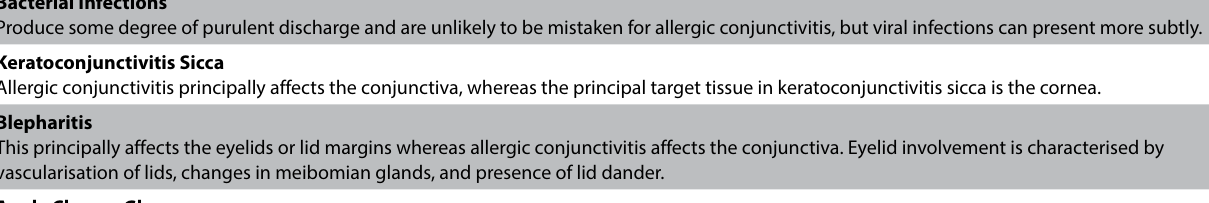
Table 3: Differential diagnosis and feature of these conditions 1,17,20 More severe forms of allergic ocular disease: 1. Vernal keratoconjunctivitis : more severe disorder, which usually affects boys living in warm, dry climates. It presents with intense pruritis, string mucoid discharge and cobblestoning on the upper tarsal conjunctiva and may vary with seasons 2. Giant papillary conjunctivitis : a hypersensitivity reaction to contact lenses, ocular sutures or ocular implants. It presents with itching, foreign body sensations, giant papillae. 3. Atopic keratoconjunctivitis : chronic and severe disorder that can affect the eyelid, conjunctiva, and cornea. It presents with severe pruritus, sometimes with seasonal variability. Eyelids can become thickened and